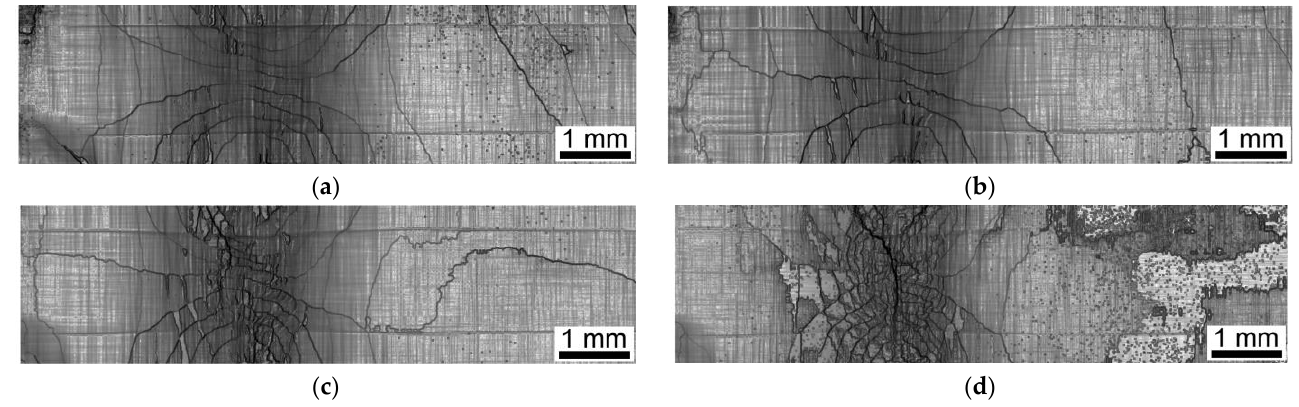
Figure 10. Evolution of deformation structures at the second stage: ( a ) ε = 0.074, ∆ ε = 0.024; ( b ) ε = 0.094, ∆ ε = 0.016; ( c ) ε = 0.118, ∆ ε = 0.020; ( d ) ε = 0.138, ∆ ε = 0.024 All pseudo-images on ( a – d ) are obtained at T = 1.